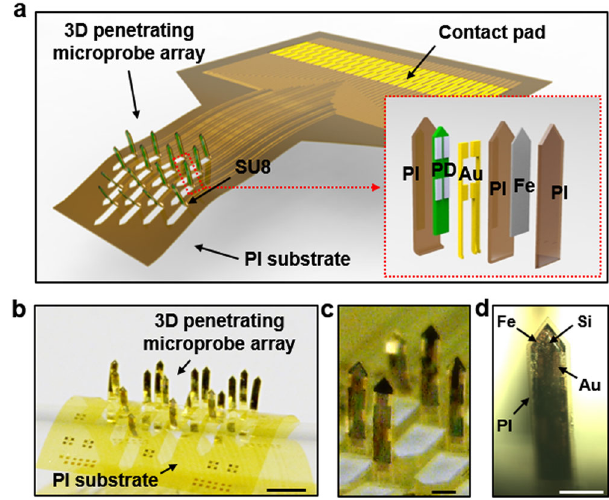
Fig. 1 Flexible 3D penetrating microprobe array. a A schematic illustration of the fl exible 3D penetrating microprobe array. The inset is an exploded structure of a single probe. b An optical image of 3D penetrating microprobe array on a curved surface. (scale bar, 2 mm). c An optical image of microprobes. (scale bar, 500 μ m). d An optical microscopic image of a single microprobe. (scale bar, 500 μ